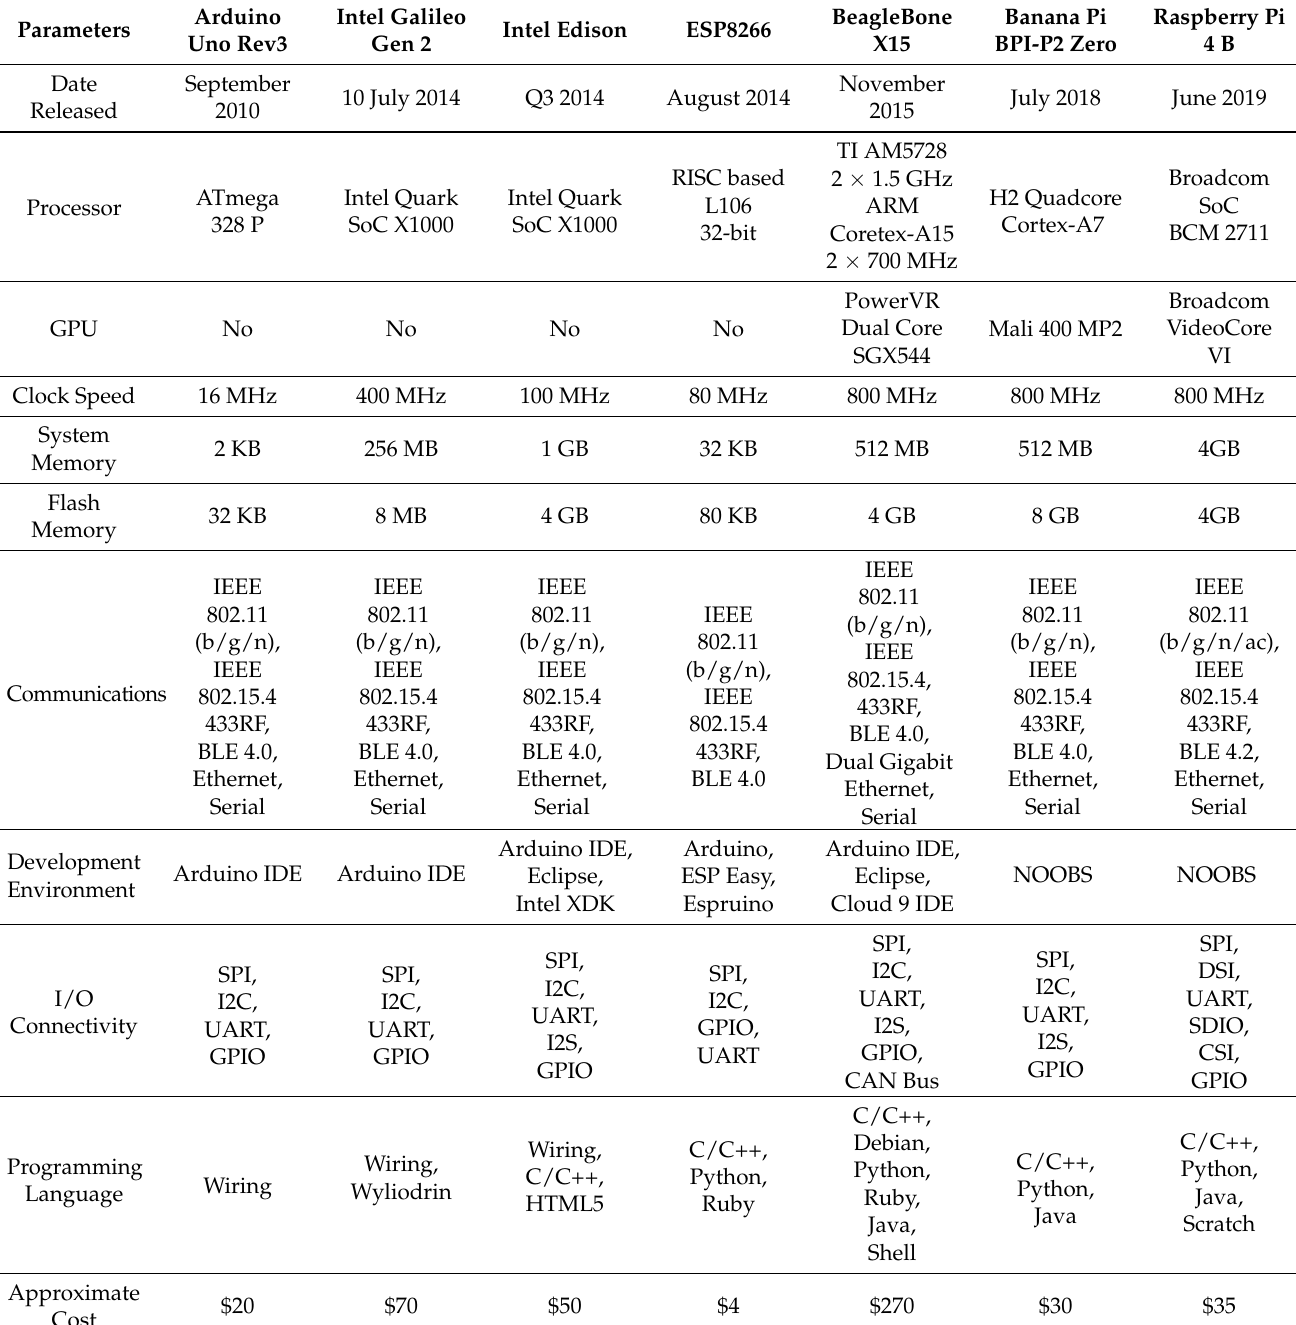
Table 5. Comparison of IoT supported latest hardware